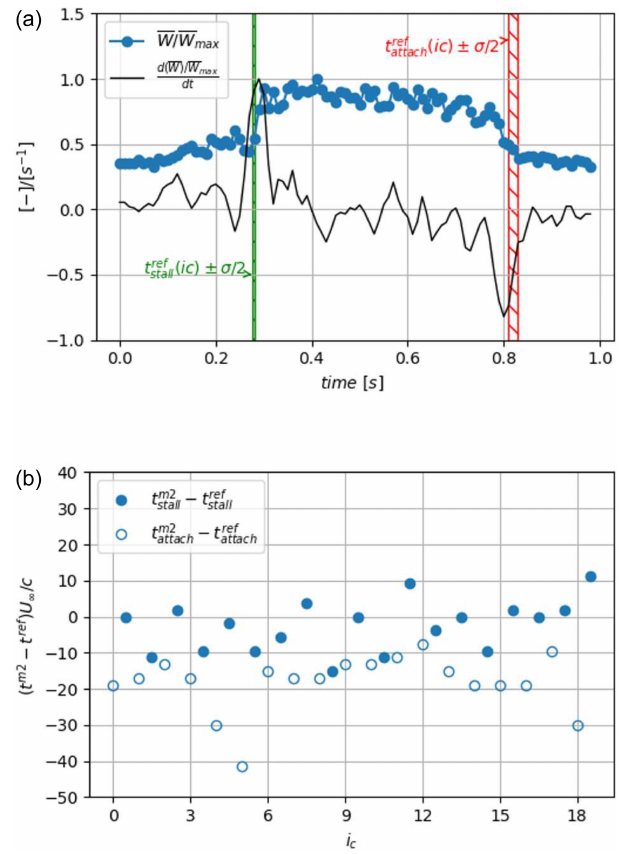
Figure 17. Second method to detect the flow stall–reattachment in- stants. (a) The phase average signal W ( t ) with its time derivative d W ( t ) ; (b) results of the zero-crossing method to extract the flow d t stall–reattachment instants using the second method, t m 1 ( i c ) and stall t m 1 ( i c ), compared to reference instants. The time window width attach marked by green and red hatched areas corresponds to the stan- dard deviation σ ( t ref ( i c ) − i c .T ) centered on the aver- (stall − or − attach) age of the reference instants extracted from the instantaneous veloc- ity fields of Sect. 4.1, t ref ( i c ) or t ref ( i c ). The filled circle symbols stall attach correspond to stall instants, and void circle symbols correspond to reattachment instants.